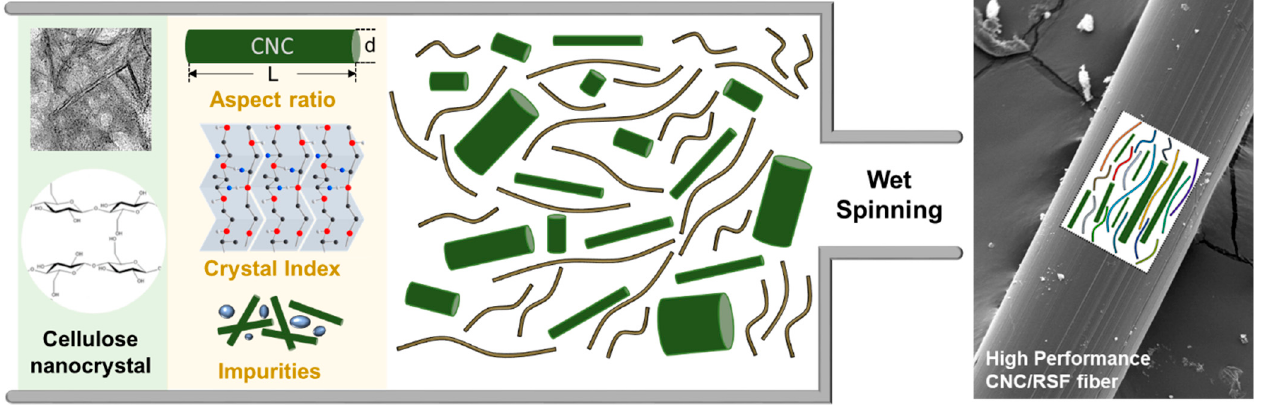
Figure 1. Illustration of fiber formation with CNC and RSF. Three different characteristics of CNC, such as (1) aspect ratio, (2) crystal index, and (3) impurities, influence the properties of the composite fiber including alignment and crystallinity, resulting in different mechanical features.